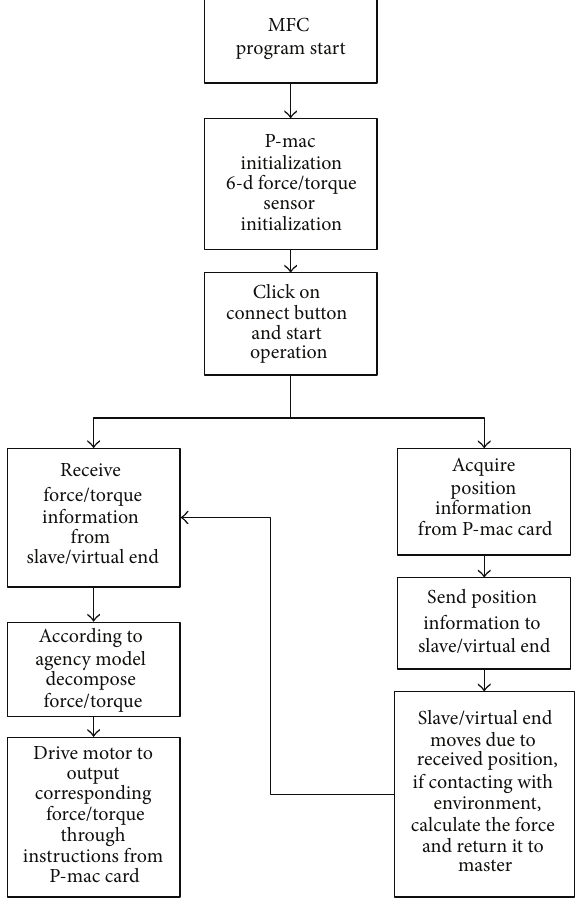
Figure 7: PC control software flow chart.